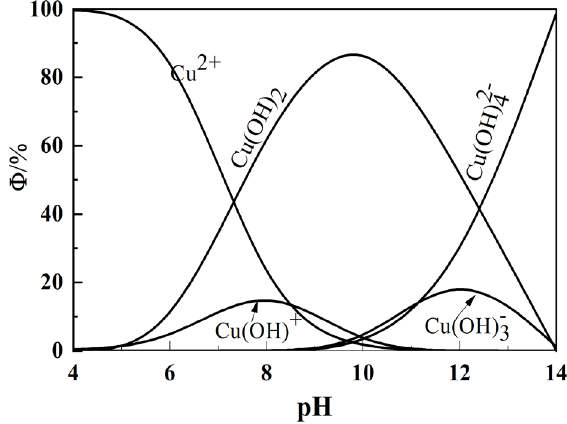
Figure 6. Distribution chart of Cu 2 + composition and solution pH value.